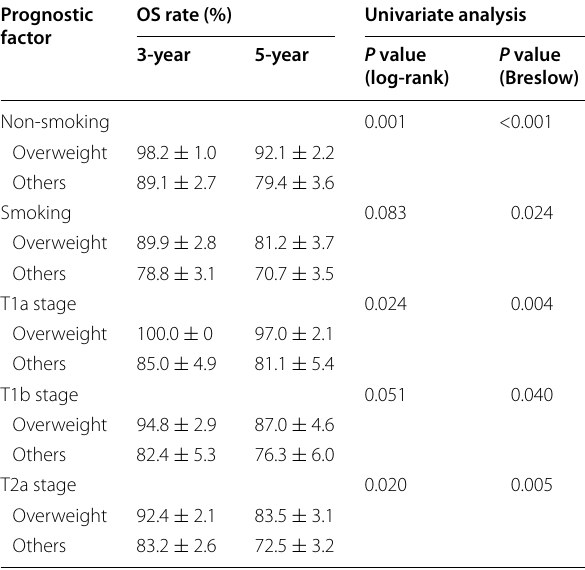
Table 5 Subgroup OS analysis for stage I NSCLC patients in the overweight group and other groups, stratified by smoking status and T stage